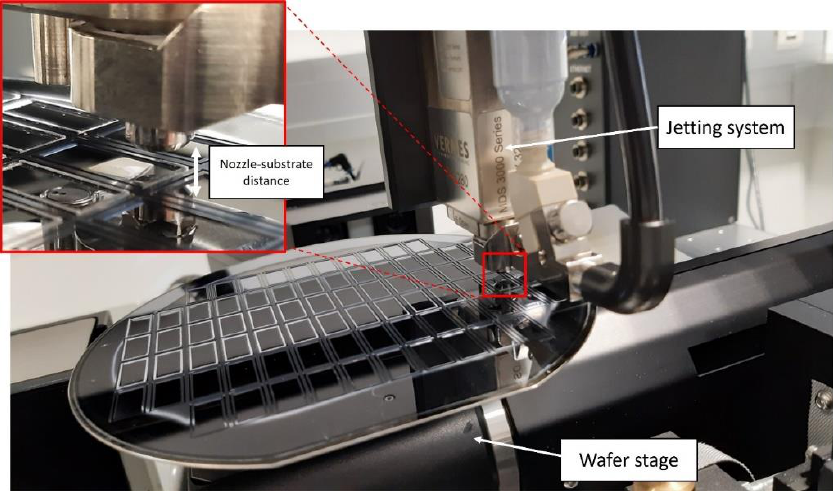
Figure 1. Two optical images of the wafer-level glass frit jetting in action. For the wafer-level jetting experiments, silicon cap wafers with a diameter of 150 mm and thickness of 500 µ m were used. Here, cavities with a depth of 200 µ m and area of L: 14.6 mm and W: 6.2 mm were dry-etched. Each cavity possessed a bond frame with a width of 500 µ m. The glass frit paste was jetted on the bond frame at 4 different pitch sizes (center to center distance) of 200, 225, 250 and 300 µ m with an average width of 225 µ m. The printed structures were pre-treated in a convection oven at 430 ◦ C. Afterward, glass wafers (MEMpax ® , Schott AG, Mainz, Germany)with a thickness of 200 µ m were bonded to the cap wafers under a low vacuum (10 Pa) using a wafer bonder (EVG 520 IS, EV Group, Florian am Inn, Austria) at 460 ◦ C. The bonding time and force were defined to be 30 min and 2000